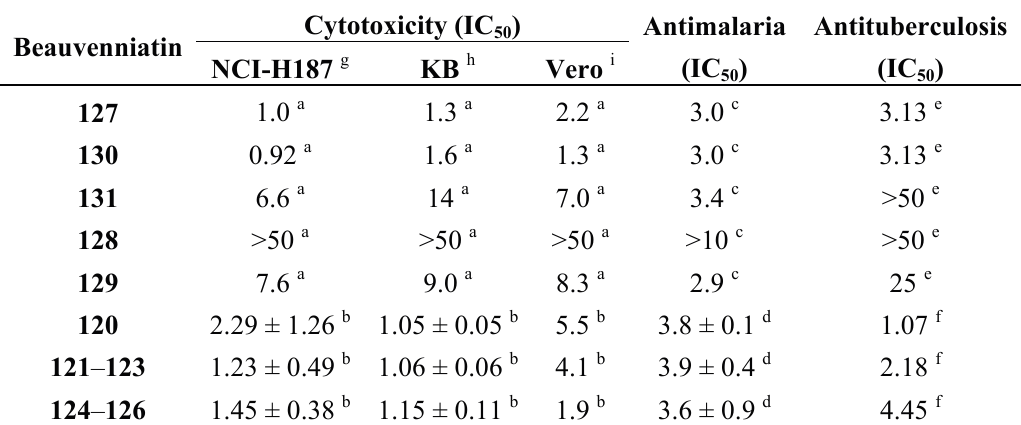
Table 3. Biological activity of beauvenniatins 120 – 131 .